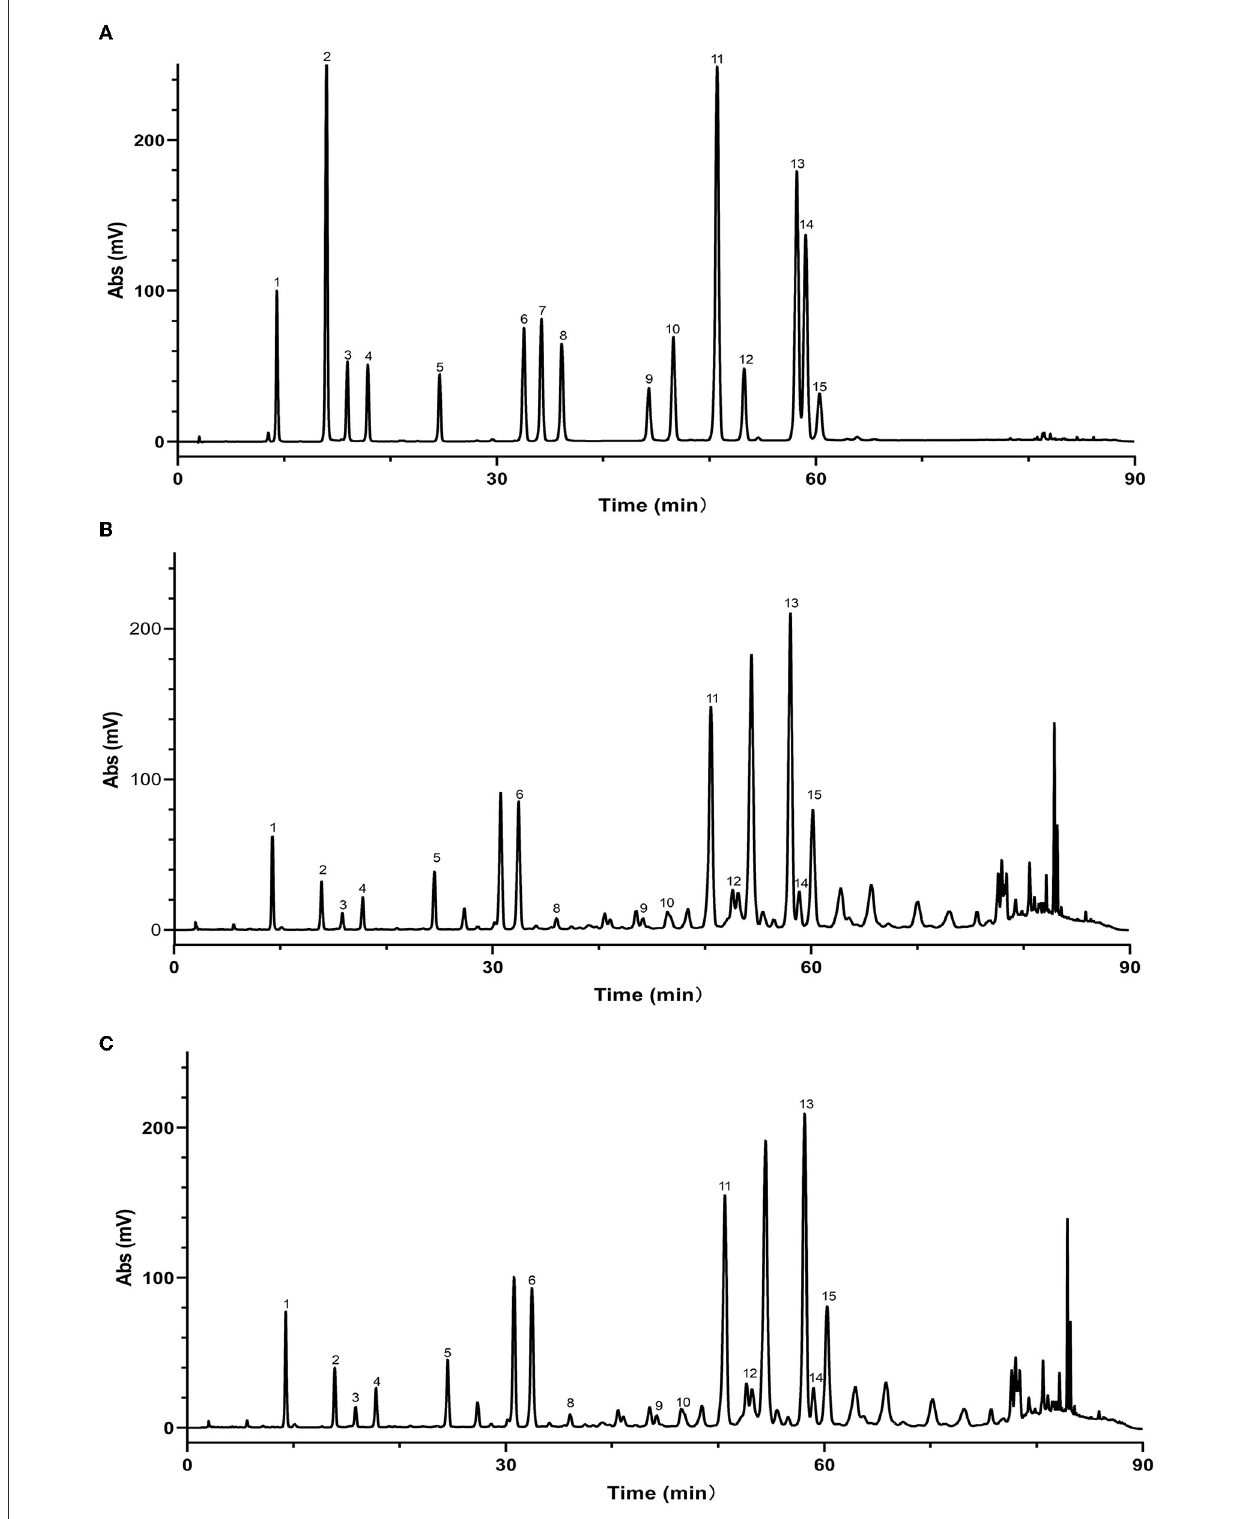
FIGURE6 High performance liquid chromatograms of maceration extract and ultrasound extract. (A) Standard; (B) maceration extract; (C) ultrasound extract. 1. Caffeic acid; 2. p -Coumaric acid; 3. Ferulic acid; 4. Isoferulic acid; 5. 3,4-Dimethoxycinnamic acid; 6. Pinobanksin; 7. Naringenin; 8. Quercetin; 9. Kaempferol; 10. Apigenin; 11. Pinocembrin; 12. Caffeic Acid Benzyl Ester; 13. Chrysin; 14. Caffeic acid phenethyl ester; 15.